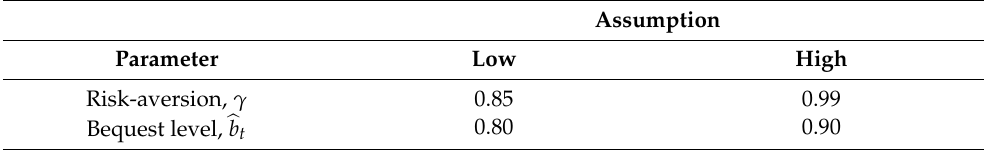
Table 2. The Parameter Values for the Optimization Model.